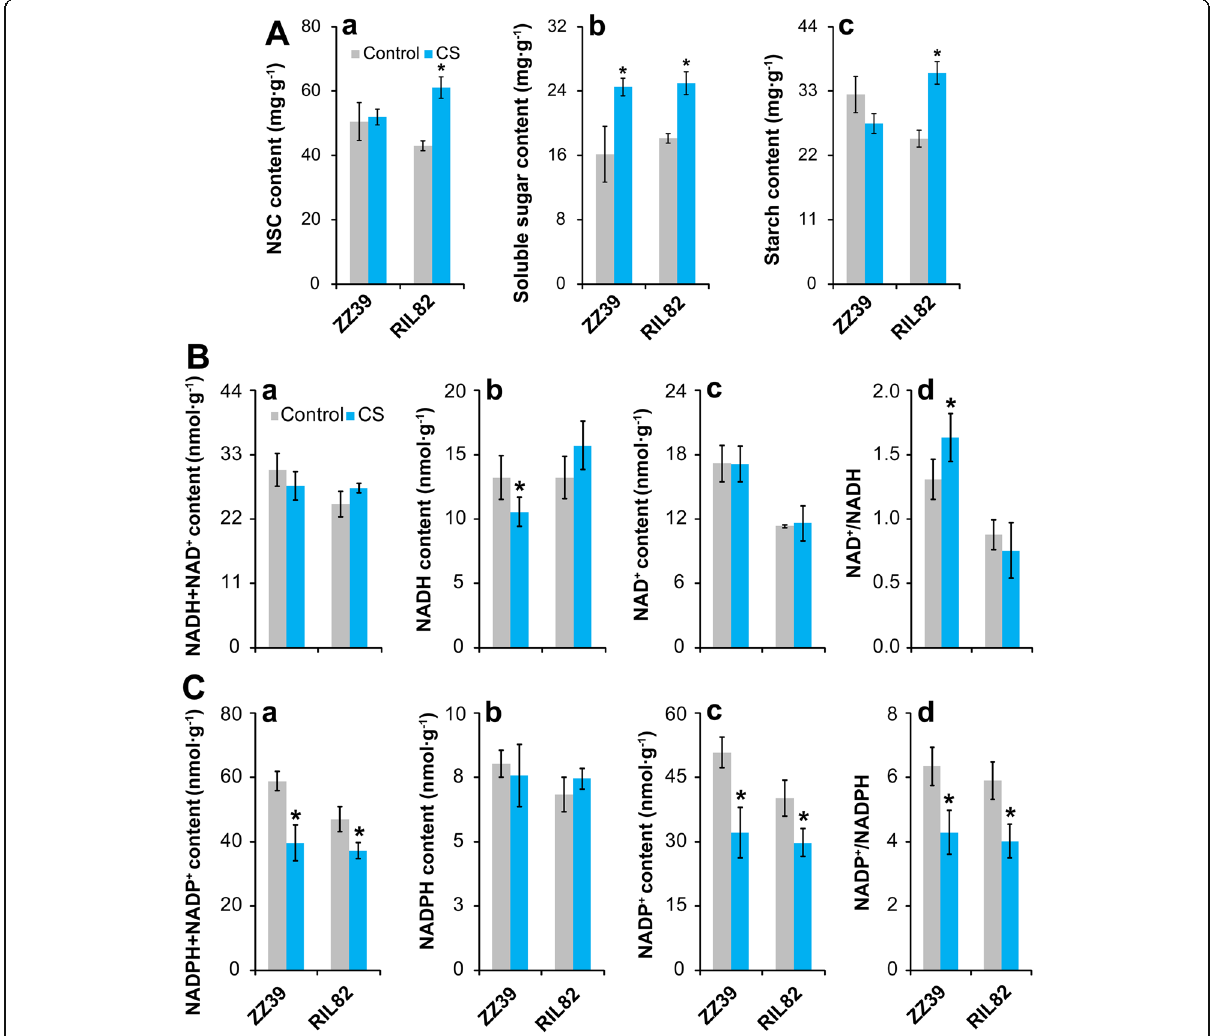
Fig. 4 Effects of cold stress on carbohydrate, NAD(H) and NADP(H) contents in rice leaves. a , Carbohydrates; b , NAD(H) metabolism; c , NADP(H) metabolism. NSC, Non-structural carbohydrates; NAD(H), Nicotinamide adenine dinucleotide; NADP(H), Nicotinamide adenine dinucleotide phosphate. Vertical bars denote standard deviations ( n = 4). A t -test was conducted to compare the difference between control and cold stress within a cultivar. * denotes P <